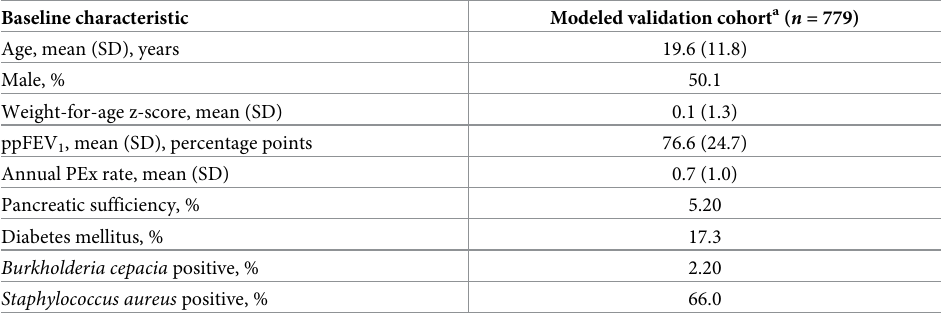
Table 2. Demographics and baseline characteristics for validation cohort from the Volkova study a